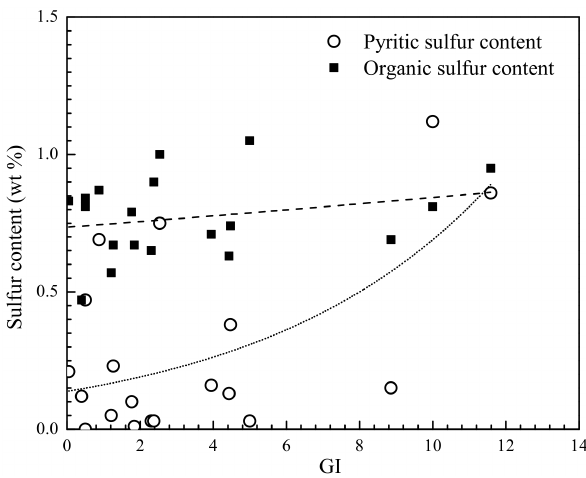
Figure 14. Relationship between huminite and sulfur contents.